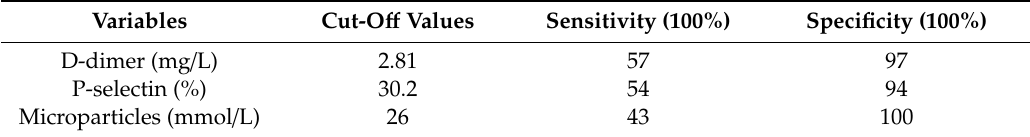
Table 2. Sensitivity, specificity and predictive cut-o ff values of D-dimer, P-selectin and microparticles for the diagnosis of